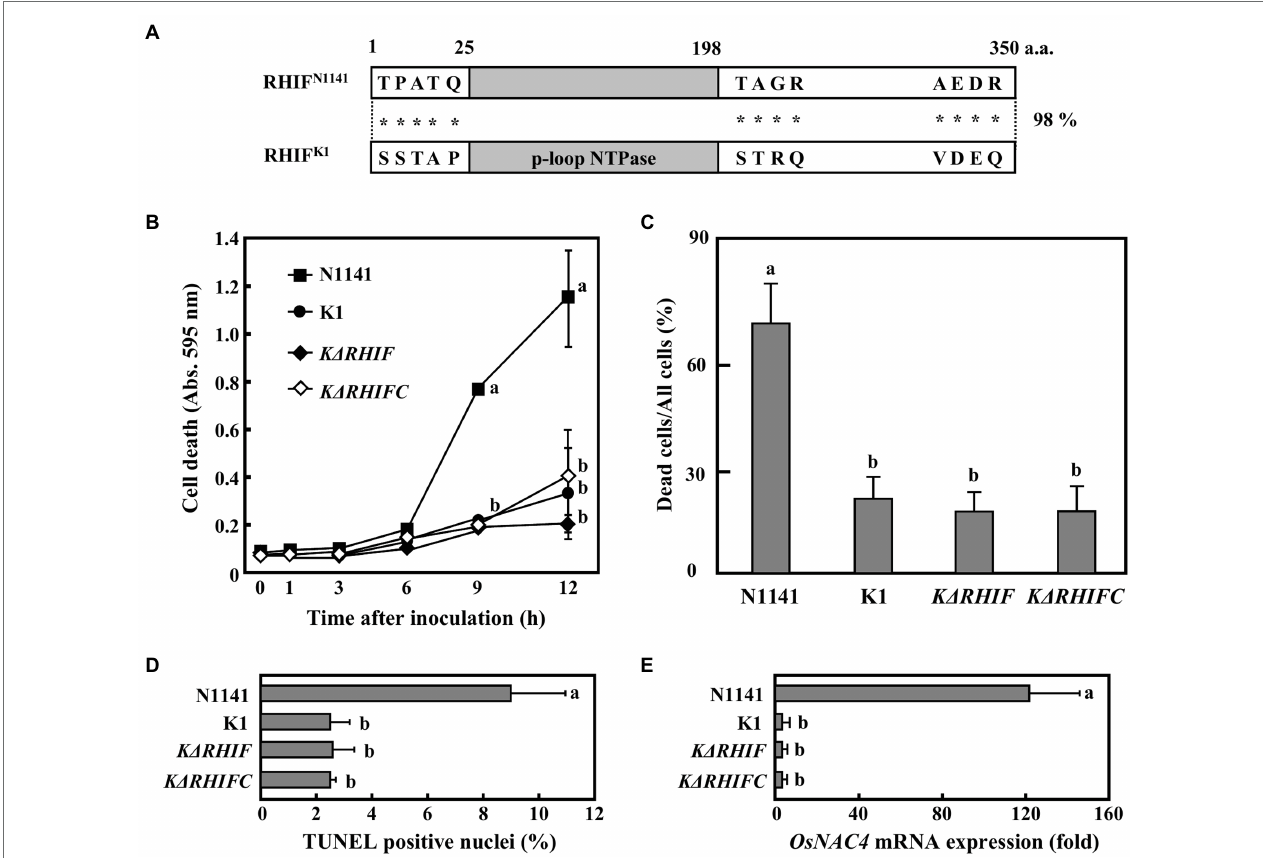
FIGURE 5 | Role of KRHIF in induction of rice ETI. (A) Schematic drawing of RHIFs. Gray box indicates the p-loop NTPase domain. Asterisks indicate non- conserved amino acid residues. (B) Time course of HR cell death in cultured rice cells inoculated with N1141 (solid square), K1 (solid circle), K Δ RHIF (solid rhomb), or K Δ RHIFC (open rhomb). That time point values without letters indicate no statistical significance. (C) Percentage of dead cell in leaf sheath sections. Rice sheath cross-sections 6 h after treatment with N1141, K1, K Δ RHIF and K Δ RHIFC were monitored for dead cells by Evans blue staining. Each determination was done with at least 100 cells in each experiment. (D) Percentage of TUNEL-positive nuclei in cultured rice cells inoculated with N1141, K1, K Δ RHIF , and K Δ RHIFC . The percentage of TUNEL-positive nuclei was determined by counting nuclei within 10 individual fields. Each determination was done with at least 1,000 nuclei in each of three independent experiments. (E) OsNAC4 mRNA levels in cultured rice cells inoculated with N1141, K1, K Δ RHIF , and K Δ RHIFC . The x-axis represents the fold change in mRNA levels relative to those in cultured cells prior to treatment. Error bars in figures represent standard deviation of three independent experiments. Values followed by a different letter in figures were significantly different according to Tukey-Kramer test ( p <